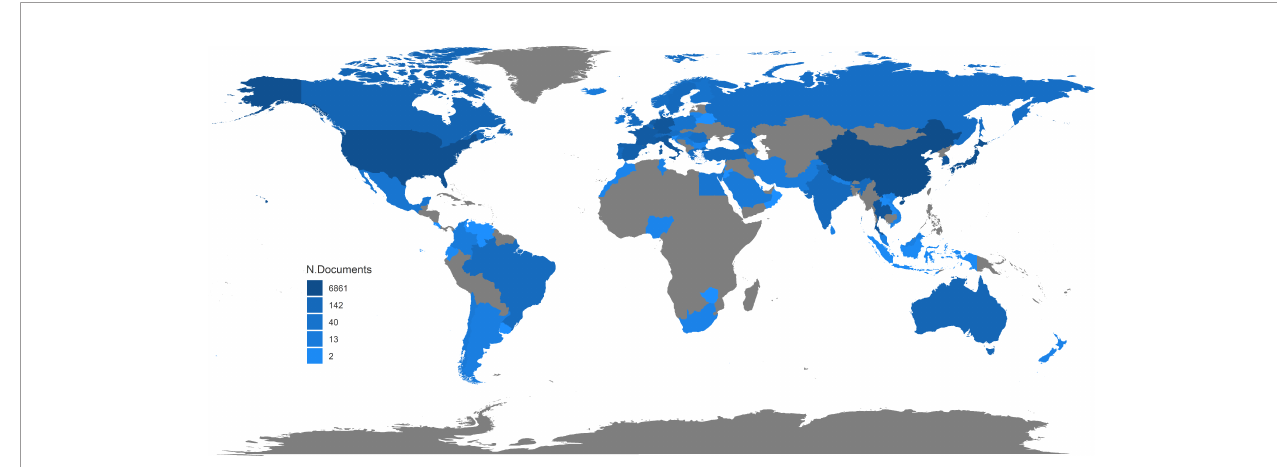
FIGURE 3 | Country scienti fi c